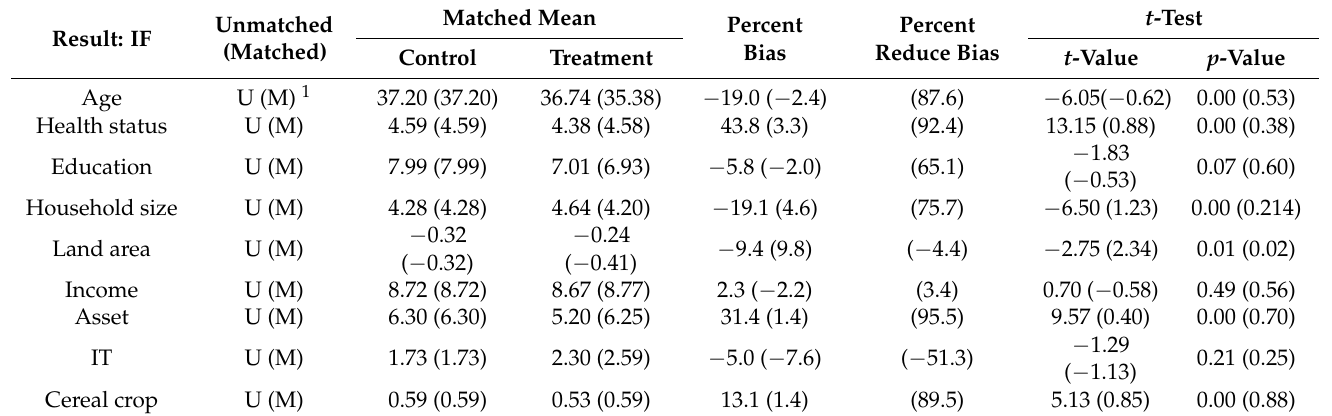
Table 5. Propensity score matches balance test outcomes.